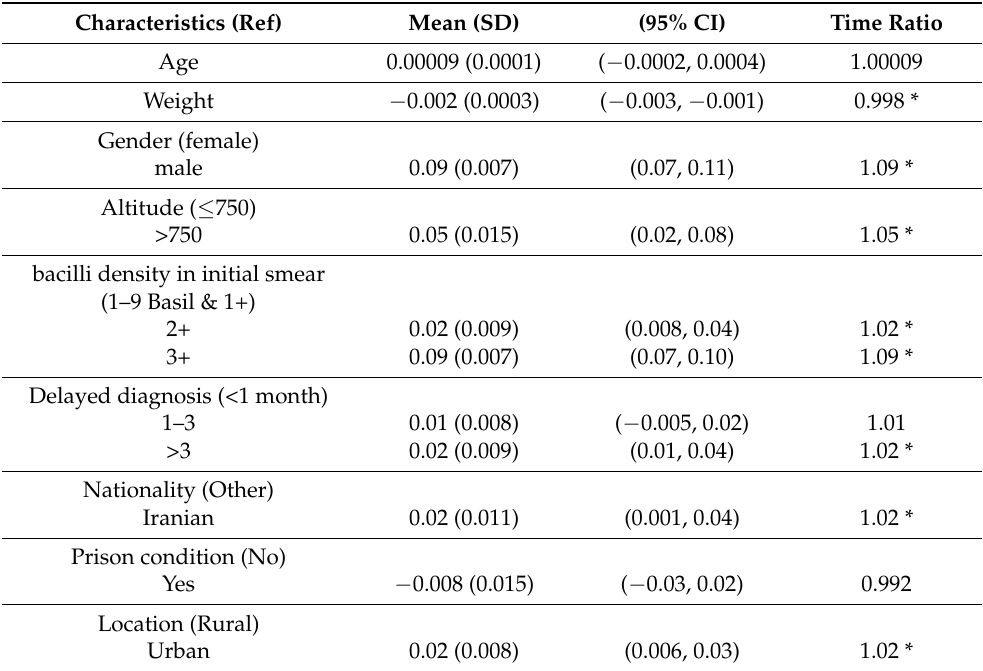
Table 3. The results from the best fit AFT spatial model (Spatial log-logistic model with Convolution